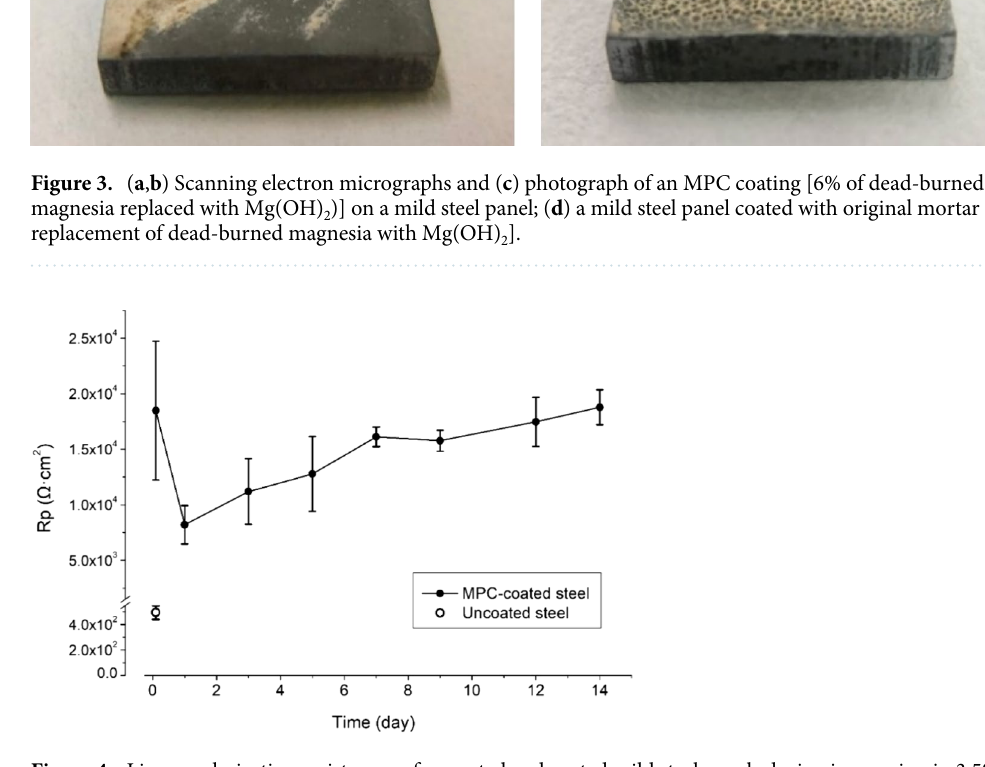
Figure 4. Linear polarization resistances of uncoated and coated mild steel panels during immersion in 3.5% NaCl